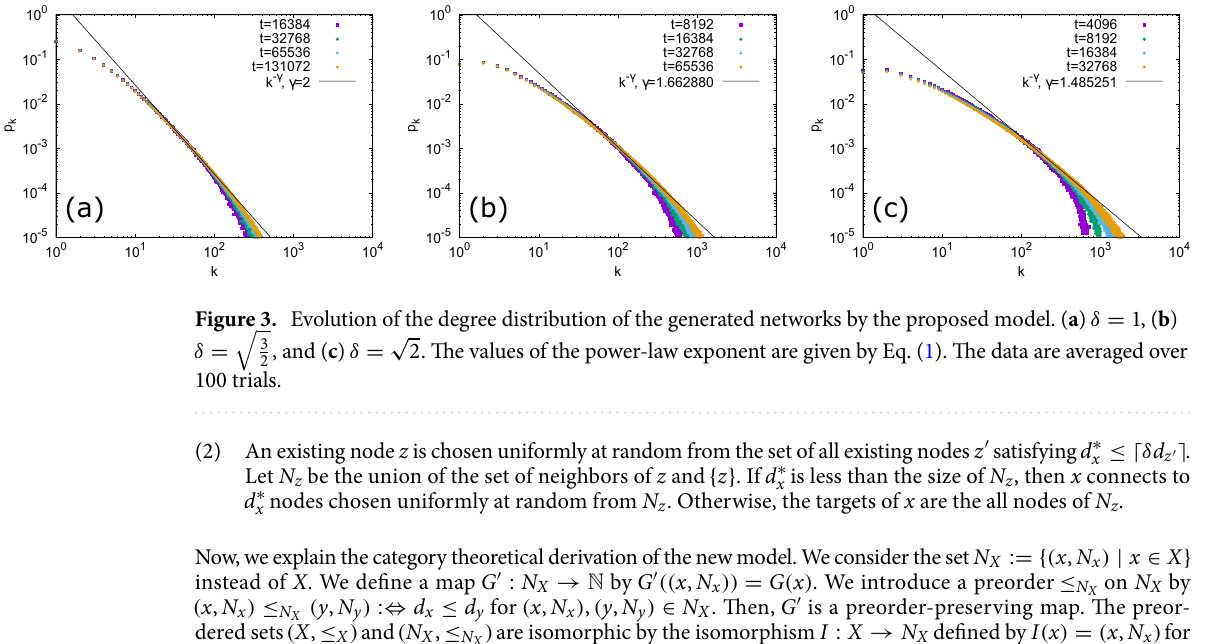
Figure 3. Evolution of the degree distribution of the generated networks by the proposed model. ( a ) δ 3 √ 2 . The values of the power-law exponent are given by Eq. (1). The data are averaged over δ δ 2 , and ( c ) = (cid:31) = 100